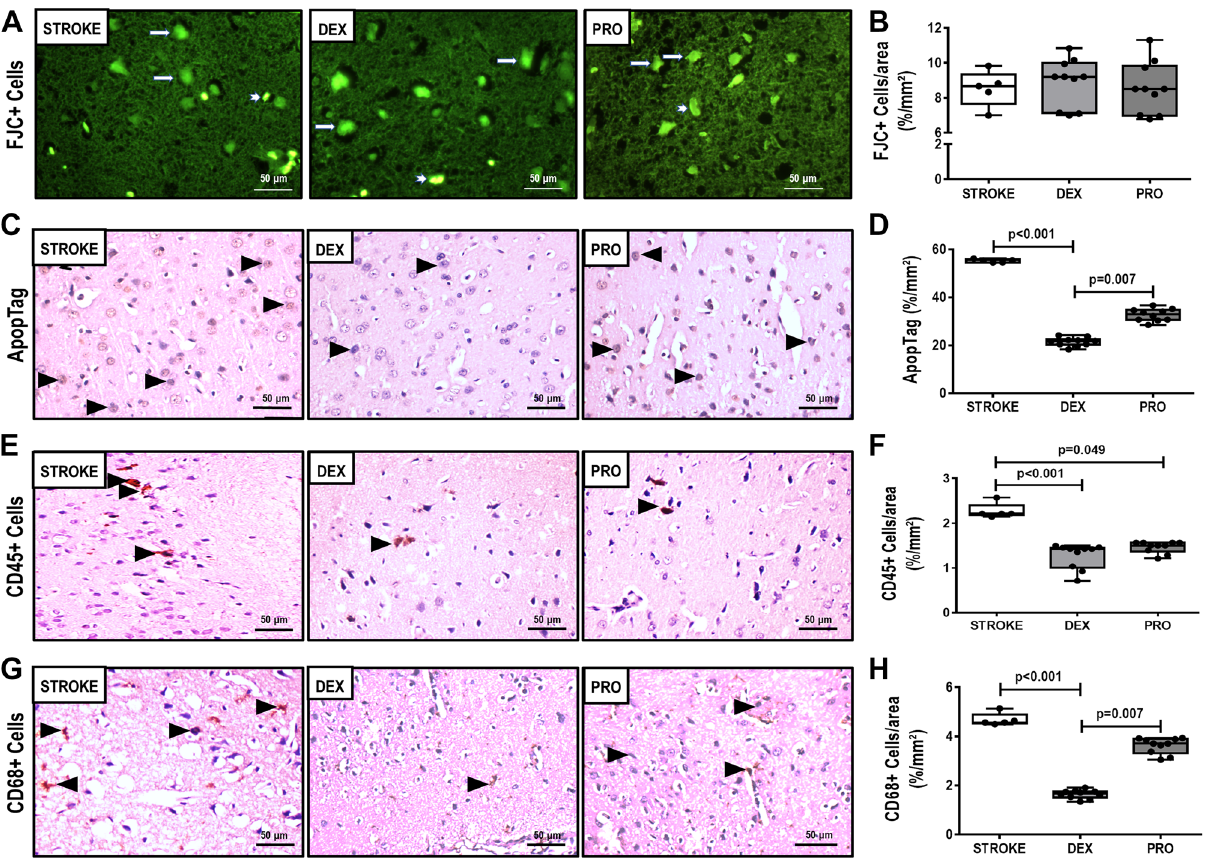
Figure 3. All animals were submitted to focal ischemic stroke. 24-h later, they were randomly assigned, by sealed envelopes, to (1) Group STROKE; (2) Group DEX; and (3) Group PRO. After 1-h of anesthetic infusion, brain was removed for Fluoro-Jade C staining and immunofluorescence, ApopTag kit detection, and immunohistochemical analysis for CD45 + and CD68 + cells. ( A ) Images showing staining of all degenerating neurons by FluoroJade C, which is expressed by the number of FluoroJade C-positive cells per area (%/mm 2 ) in STROKE, DEX and PRO groups. ( B ) Quantification of FluoroJade C-positive cells per area (%/mm 2 ). ( C ) Images showing ApopTag kit staining in STROKE, DEX, and PRO groups. ( D ) Quantification of ApopTag + cells per area (%/mm 2 ). No difference was observed between STROKE and PRO groups in relation to ApopTag + cells per area (%/mm 2 ) ( p = 0.188). ( F ) Images showing CD45 + cells in STROKE, DEX and PRO groups. ( E ) Quantification of CD45 + cells per area (%/mm 2 ). No difference was observed between DEX and PRO groups in relation to CD45 + cells per area (%/mm 2 ) ( p = 0.247). ( F ) Images showing CD68 + cells in STROKE, DEX and PRO groups. ( G ) Quantification of CD68 + cells per area (%/mm 2 ). No difference was observed between STROKE and PRO groups in relation to ApopTag + cells per area (%/mm 2 ) ( p = 0.188). Box plots represent the median and interquartile range of 5 animals in STROKE, DEX, and PRO groups. Comparisons done by Kruskal–Wallis test followed by Dunn’s multiple comparisons test ( p <